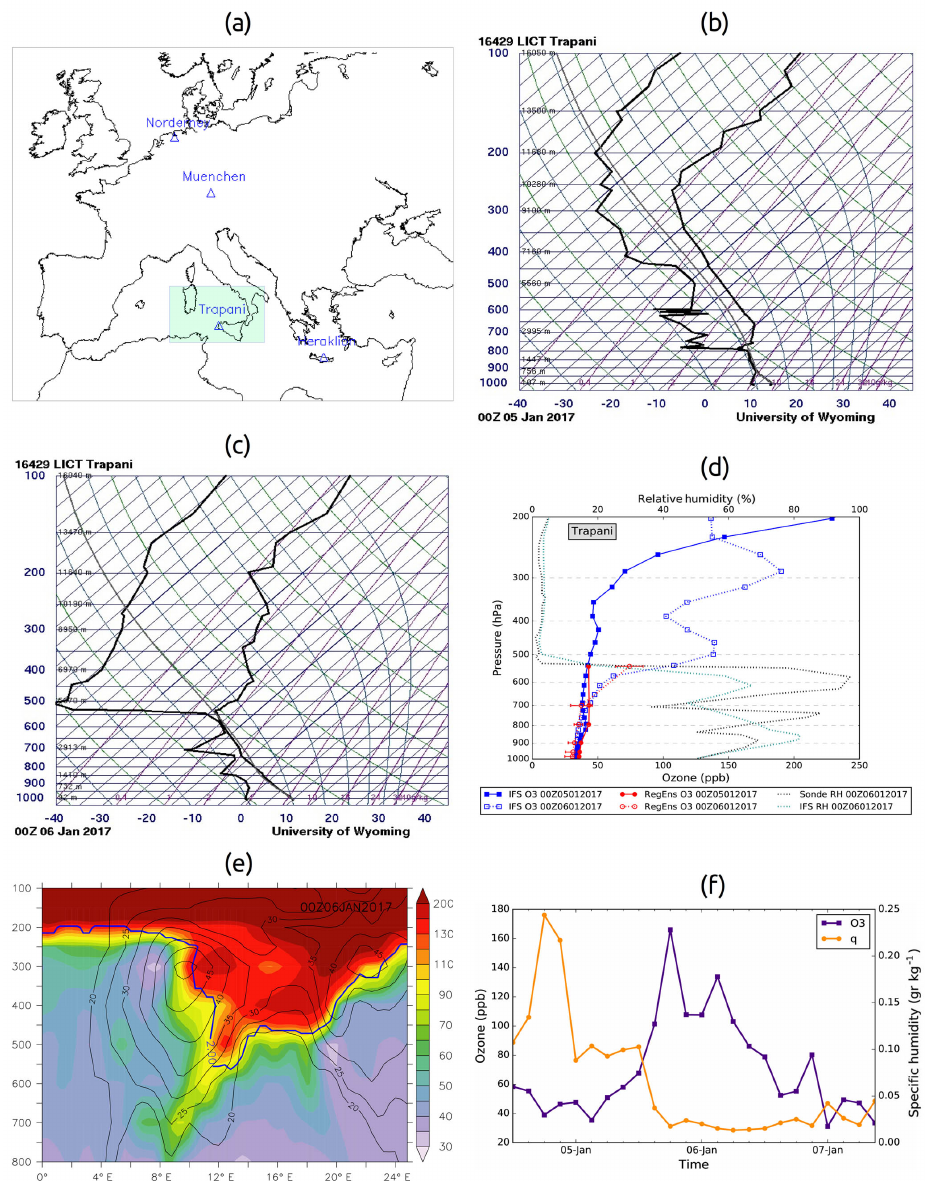
Figure 7. (a) Trapani, Italy location. (b) Skew-T log-P diagrams at 00:00Z on 5 January 2017 and (c) 00:00Z on 6 January 2017. (d) Vertical profiles of IFS (blue) and RegEns (red) ozone mixing ratio (ppb) at 00:00Z on 5 January 2017 (solid line) and 00:00Z on 6 January 2017 (dashed line). The red bars denote the standard deviation among the regional ensemble members. Also shown are sonde (dashed black line) and IFS relative humidity (dashed cyan line) at 00:00Z on 6 January 2017. (e) Longitude–pressure vertical cross section at 38 ◦ N of IFS ozone mixing ratio (in ppb; colour shaded), wind speed (in ms − 1 ; black contours) and PV (2pvu; blue contours) at 00:00Z on 6 January 2017. (f) IFS ozone (blue) and specific humidity (orange) time series at